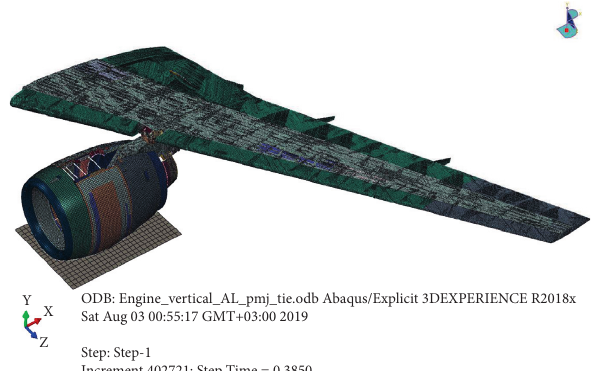
Figure 22: Vertical impact model of crash with wheels retracted.